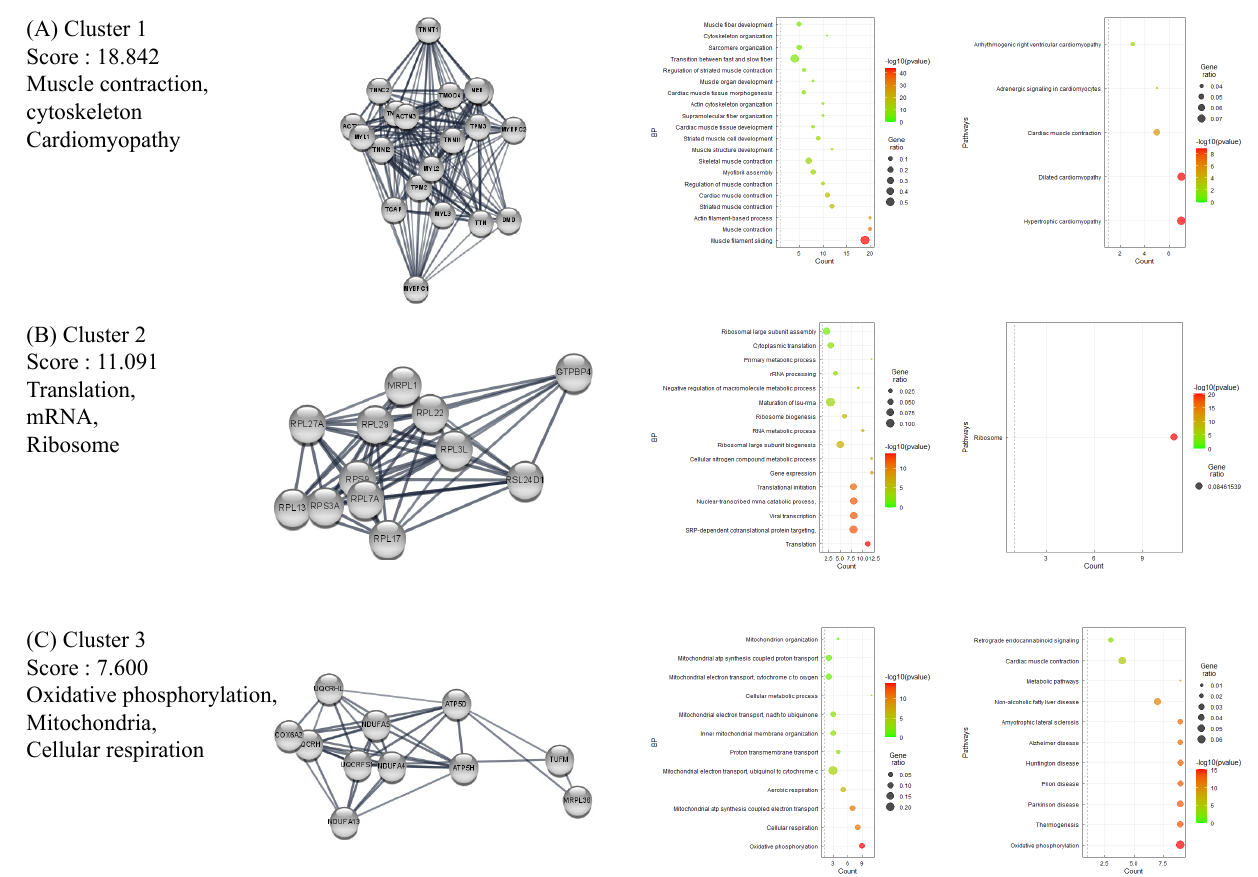
Figure 3. Functional clustering of downregulated DEGs in HT samples, using the MCODE algorithm. Results of BP and KEGG-enrichment analyses presented as dot plots. Each cluster represents a set of highly connected genes. ( A – C ) represent Cluster 1–3, respectively, which had the highest clustering